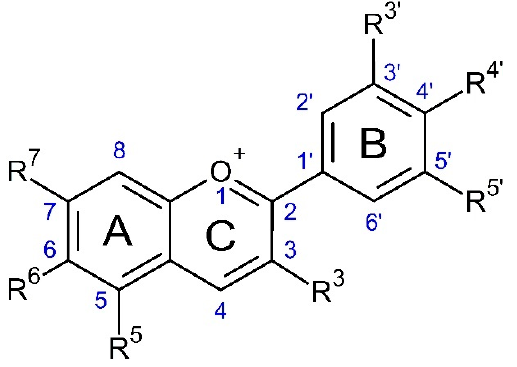
Figure 1. Basic anthocyanin structure.